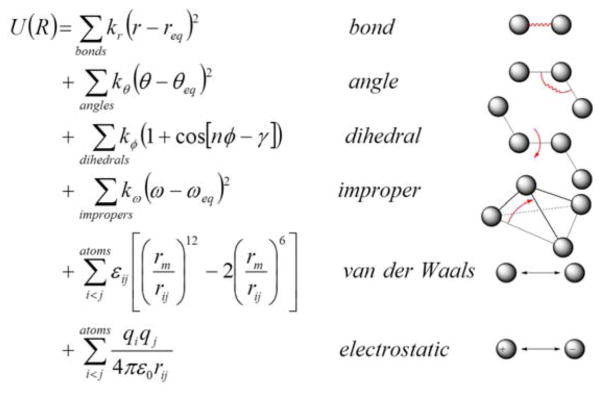
Classical force fields used for MD simulations: (Right) potential energy terms in a force field; and (Left) energy function used to derive atomic forces for molecular movement. r is the bond length; θ is the atomic angle; φ is the dihedral angle; ω is the improper dihedral angle; rij is the distance in between atom i and j; kr, kθ, kφ, and kω are force constants; req, θeq and ωeq are equilibrium positions; the dihedral term is a periodic term characterized by a force constant (kω), multiplicity (n), and phase shift (γ); εij is related to the Lennard–Jones well depth; rm is the distance at which the potential reaches its minimum; qi and qj are the charges on the respective atoms; and ε0 is the dielectric constant.